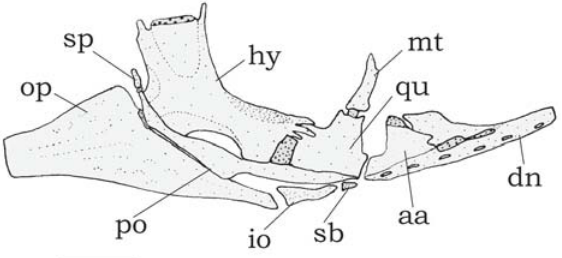
Fig. 2. Right suspensorium of Tatia gyrina , INPA 20971, 28.0 mm SL. Lateral view. Abbreviations: aa , angulo-articular; dn , dentary; hy , hyomandibula; io , interopercle; mt , metapterygoid; op , opercle; po , preopercle; qu , quadrate; sb , subpreopercle; sp , suprapreopercle. Scale bar = 1.0 mm.